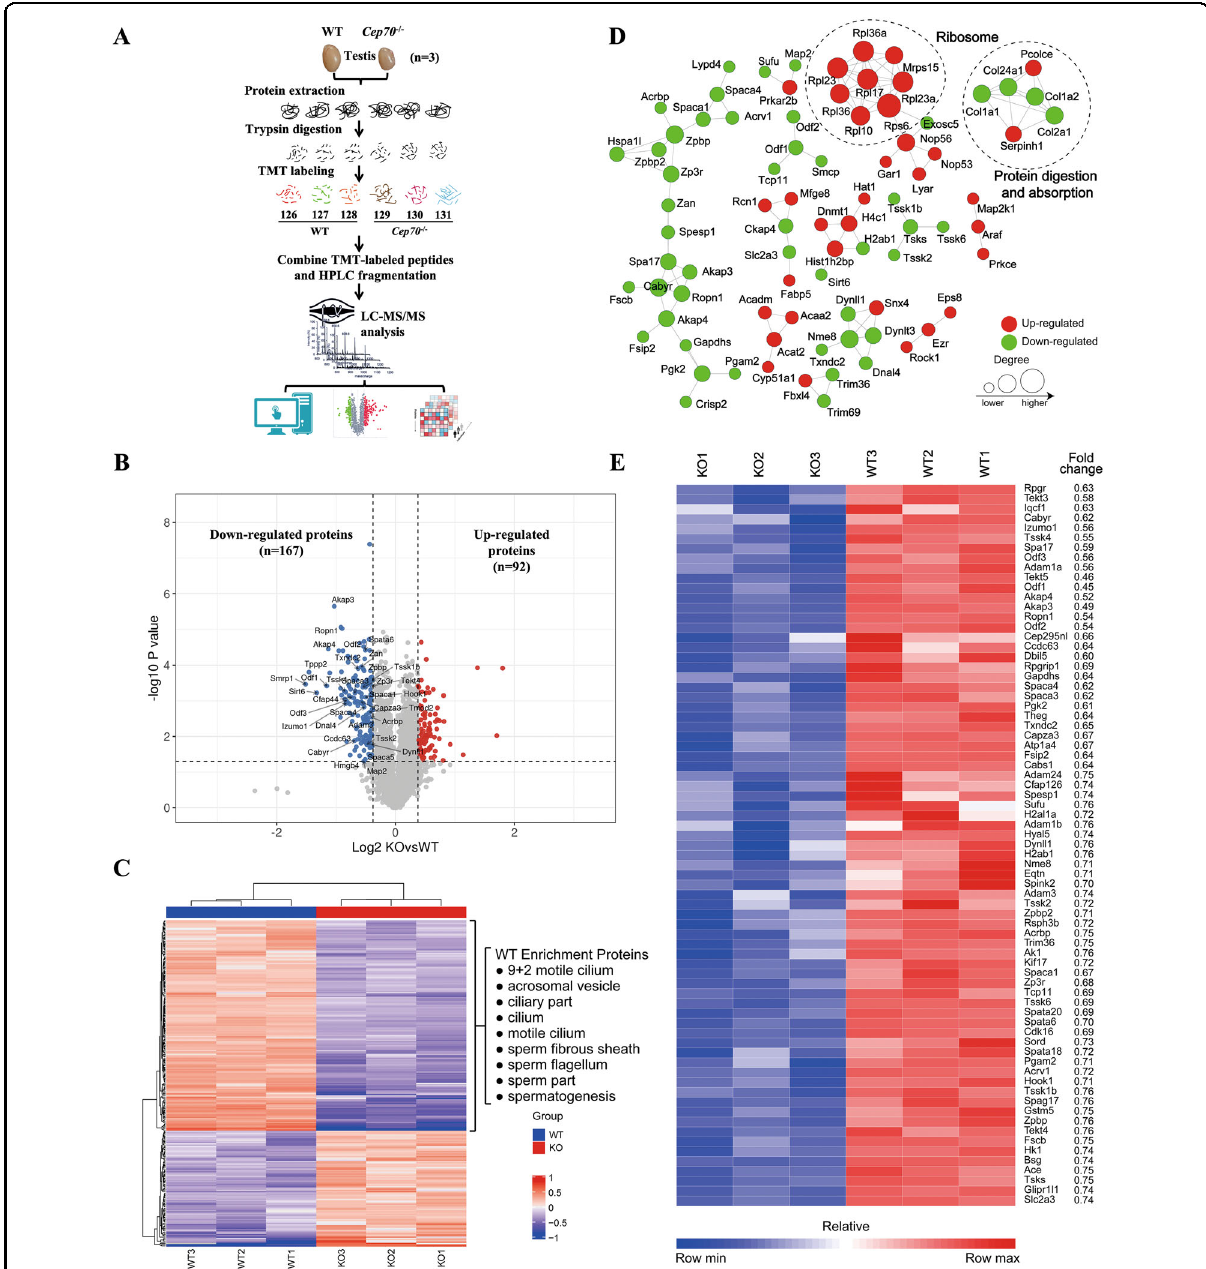
Fig. 6 Proteomics analysis veri fi ed that CEP70 participated in the regulation of acrosome and fl agella formation. A Flow diagram of testis TMT-label proteomics analysis of the WT and Cep70 − / − mice ( n = 3). B Volcano plot show the downregulated (FC < 1/1.3, blue) and upregulated proteins (FC > 1.3, red) in Cep70 − / − mice testes compared with WT testes. C The heatmap of GO terms enriched in DEPs between the WT and Cep70 − / − mice testes. D PPI network analysis revealed the biological processes of the DEPs between the WT and Cep70 − / − mice testes. E Heatmap showing the discrepancy expression level of downregulated proteins between the WT and Cep70 − / − mice